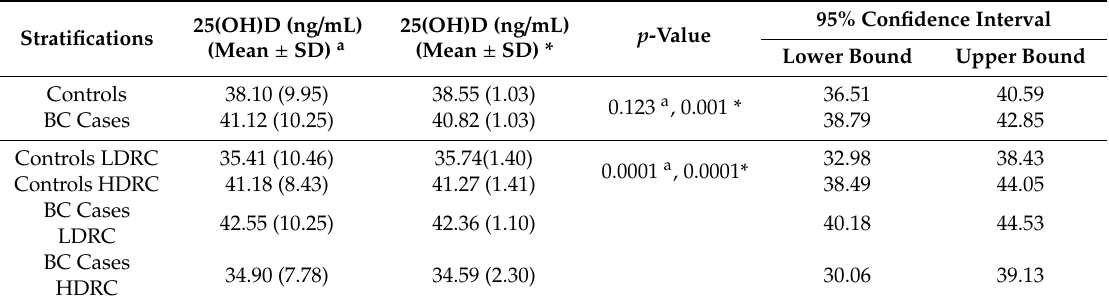
Table 2. Mean 25(OH)D level comparisons among women with and without breast cancer with low and high DNA repair capacity.